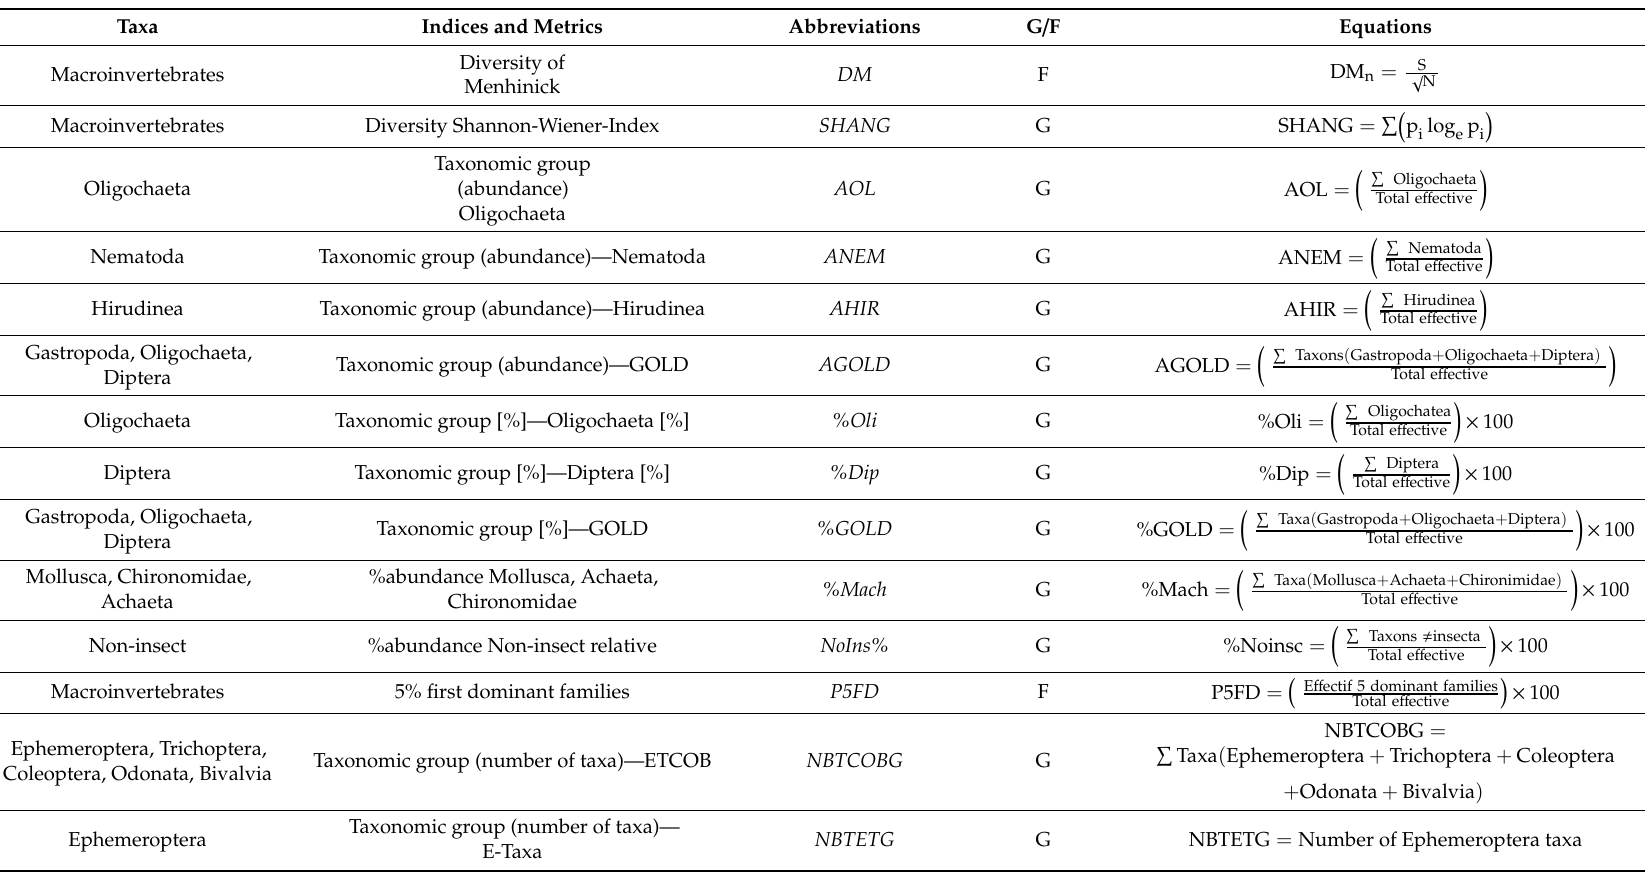
Table 3. List of taxa, metrics, and indices (with abbreviations) at the family (F) or genera (G) taxonomic levels, with equations, retained after all selection